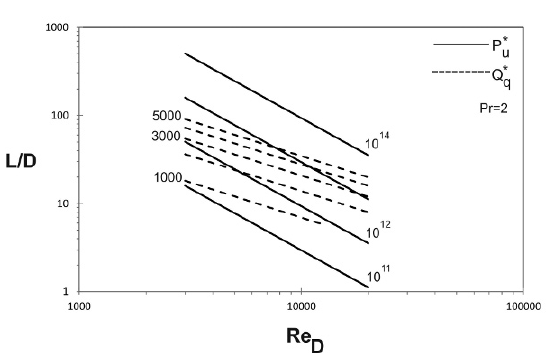
Figure 4. L/D group versus the Reynolds number for different di- mensionless heat transfer conductance and fluid pumping power (turbulent regime and constant heat-flux boundary)